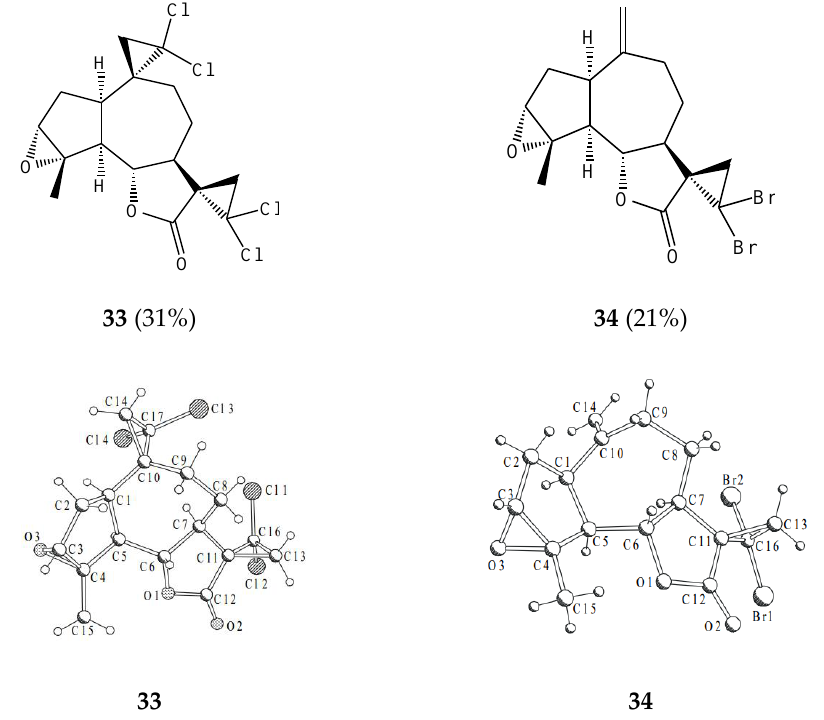
Figure 8. Spatial structure of molecules 33 and 34 according to X-ray diffraction analysis data. When lactone 1 interacted with bromoform under the conditions of d-bromocarbene